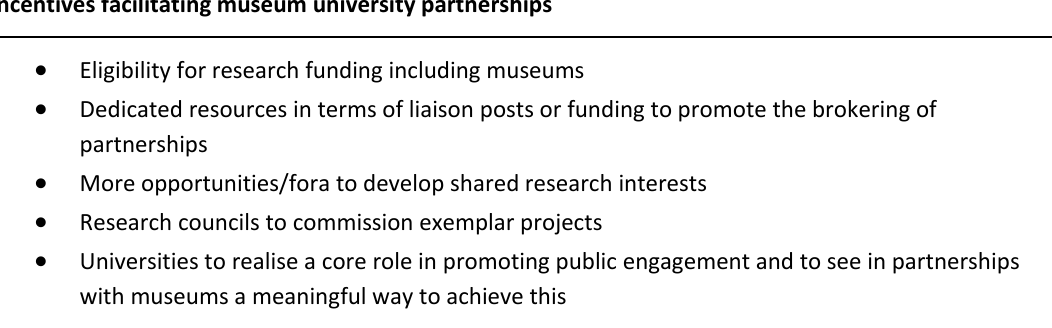
Table 2. Incentives facilitating museum university partnerships (Dawson and Gilmore 2009: